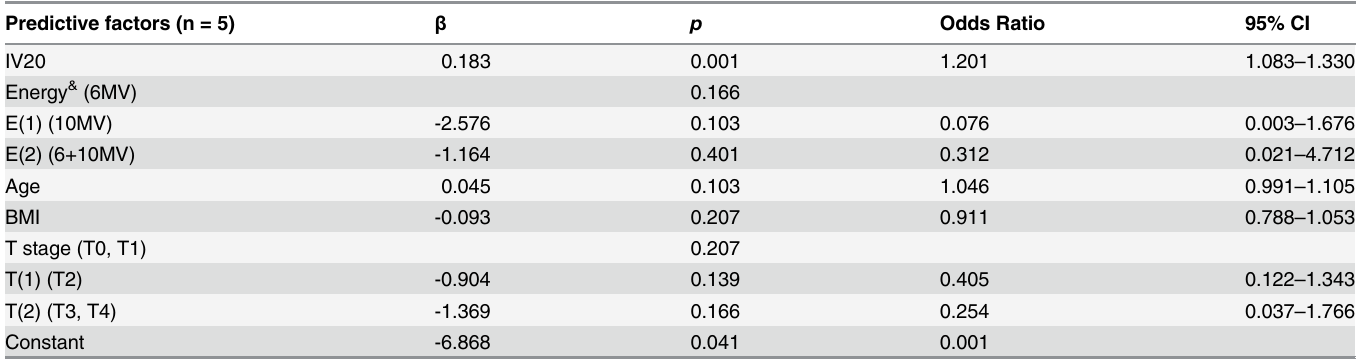
Table 4. Multivariate logistic regression coefficients and odds ratios for the NTCP